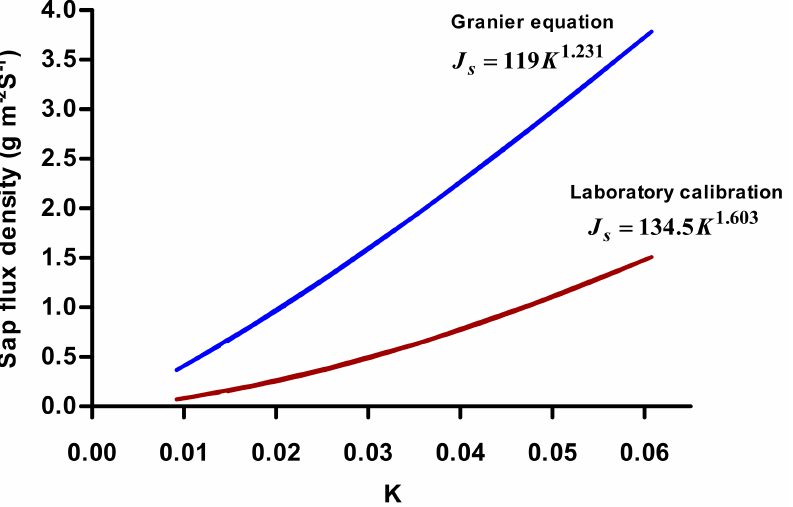
Figure 3. The relationship between sap flux density (J s ) and K estimated by laboratory calibration and Granier equation.